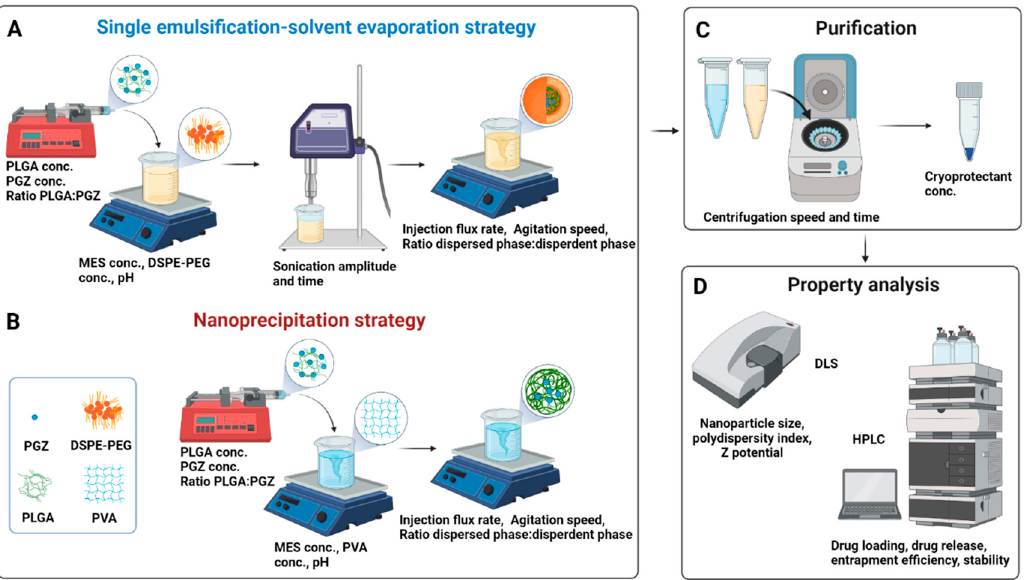
Figure 1. Synthetic workflow for the Pioglitazone-loaded PLGA nanoparticles preparation via single emulsification-solvent evaporation ( A ) or nanoprecipitation ( B ) techniques. A bubble-free non-water miscible (for A ) or water-miscible (for B ) organic solution, containing the drug and the polymer, was loaded into a syringe and injected within an aqueous solution (buffer). Nanoparticles formation needs a high shear force in the emulsification approach, while it is spontaneous in the nanoprecipitation approach thanks to phase separation. The organic solvent is then evaporated, and the nanoparticles are washed by centrifugation cycles and resuspended in a cryoprotectant solution for storage at low temperatures ( C ). Parameters that can be tuned are indicated within the panels ( A – C ). Physicochemical properties of nanoparticles are finally investigated through DLS and HPLC ( D ). Abbreviation: conc., concentration; PGZ, Pioglitazone; PLGA, Poly(D,L-lactic-co-glycolic acid); MES, 4-Morpholineethanesulfonic acid; PVA, polyvinyl alcohol; DSPE-PEG, 1,2-distearoyl-sn-glycero-3-phosphoethanolamine-N-[amino(polyethylene glycol)-2000] Carboxylic Acid; DLS, Dynamic Light Scattering; HPLC, High-performance liquid chromatography. Created with BioRender.com.